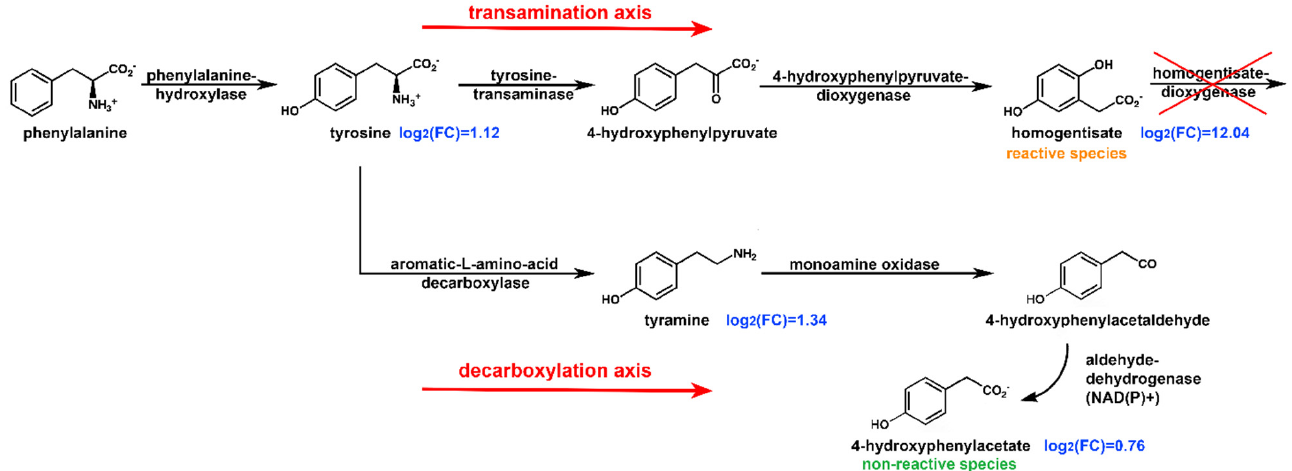
Figure 5. Alternative ways for tyrosine degradation via transamination (top) and decarboxylation (bottom) and their behavior in AKU (metabolites fold change is reported in blue color as binary logarithm). The transamination axis is interrupted at the homogentisate dioxygenase step, leading to a dramatic increase in homogentisate concentrations in urine samples. Tyrosine levels are also doubled as a consequence. The impairment of the transamination axis leads to a stimulation of the decarboxylation axis with a similar increase of tyramine and 4-hydroxyphenylacetate levels in